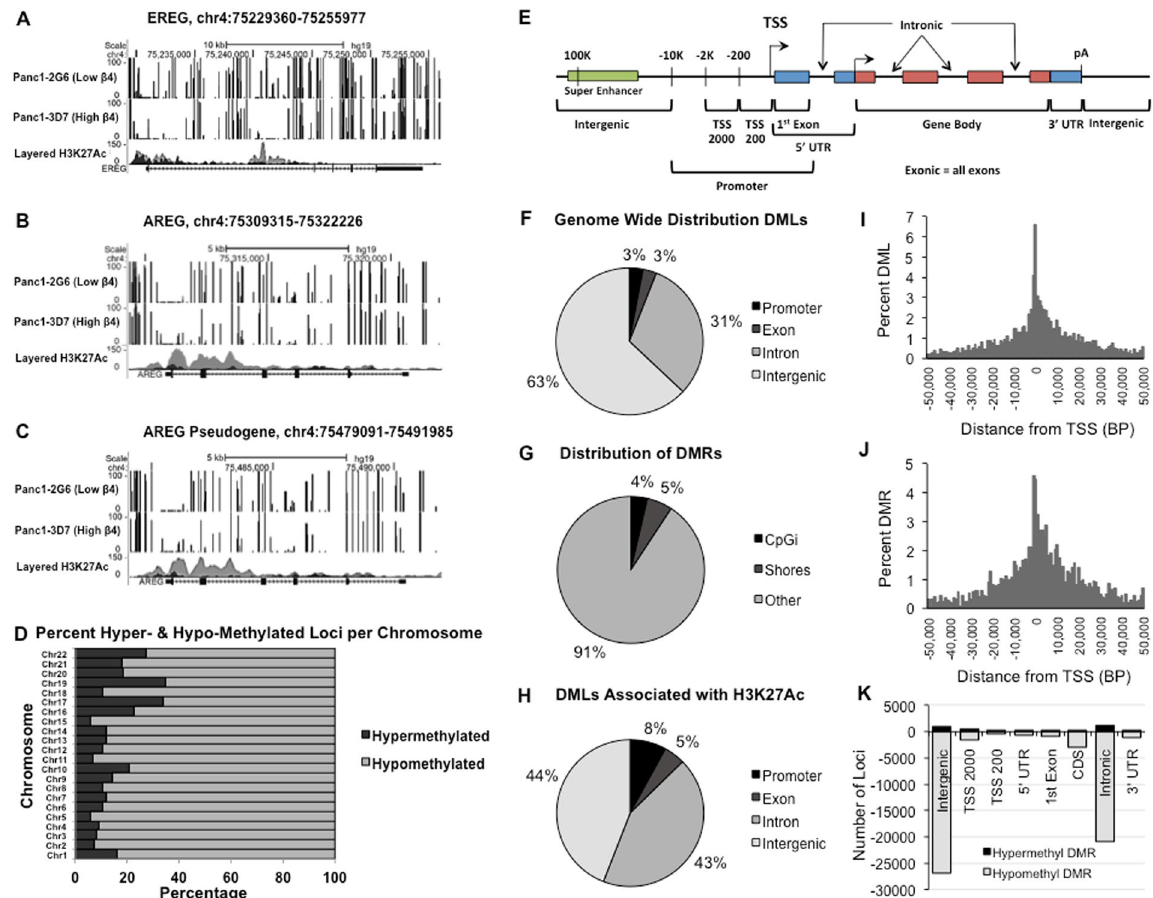
Figure 3. The integrin α 6 β 4 drives both gene specific and global DNA hypomethylation. ( A – C ) Genomic DNA from Panc1-2G6 ( β 4 low; upper panels) and Panc1-3D7 (high β 4; lower panels) was processed for high-resolution methyl-seq by the NextGen Sequencing Core at the Norris Comprehensive Cancer Center. Samples were analyzed bioinformatically and percent methylation shown for EREG ( A ), AREG ( B ), and AREG pseudogene ( C ). ( D ) Percent hypomethylation and hypermethylation per chromosome when comparing Panc1-3D7 vs. Panc1-2G6. ( E ) Defined regions of interest assessed for changes in DNA methylation ( F ) Location of DMLs across the genome. ( G ) Percent of methylation changes located in CpG islands and shores. ( H ) Location of DMLs associated with H3K27Ac. ( H ) Distance from TSSs for DMLs ( I ) Distances from TSSs for DMRs ( J ) Number of both hypomethylated and hypermethylated regions corresponding to genomic